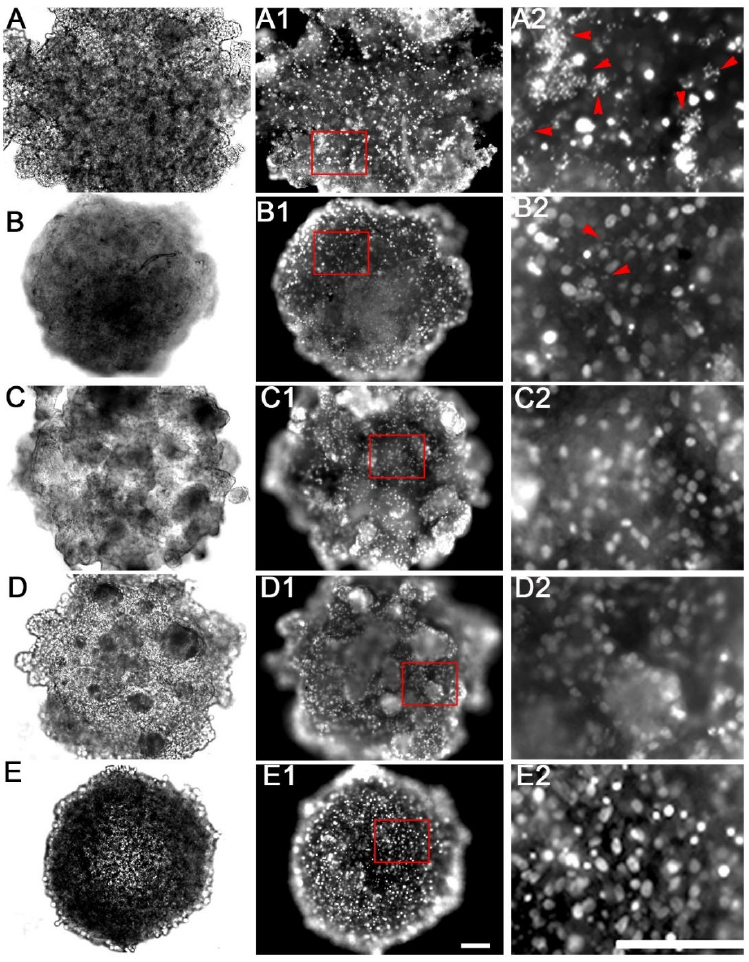
Figure 4. Effect of 3g , 3j and 3m on T. cruzi -infected microtissue. Brightfield microscopy images of spheroids from untreated T. cruzi (Dm28c-Luc) infected Vero cells ( A ), treated with Bz ( B ) or pyrazole-imidazoline derivatives ( C – E ). DAPI stained fluorescence images of untreated infected spheroid ( A – A2 ) and after 72 h-treatment with Bz ( B – B2 ), 3g ( C – C2 ), 3j ( D – D2 ) and 3m ( E – E2 ). High magnification of the spheroid region marked in red (insert) ( A – E2 ). Note the presence of intracellular amastigote on microtissue (arrowheads). The viability of intracellular parasites in the microtissue was measured, by the addition of luciferin, after 3g , 3j , 3m , and Bz treatment (72 h). The luminescence intensity data, represented as arbitrary luminescence unit (ALU), revealed a high parasite load in untreated infected microtissues (ALU = 175,040 ± 24,826) (Figure 5). A significant reduction in the viability of intracellular parasites was demonstrated with 3g (ALU = 36,130 ± 5764), 3j (ALU = 39,001 ± 9952), and 3m (ALU = 12,683 ± 3976) compared to the untreated infected microtissues (Figure 5). Among the compounds analyzed, 3m stands out for reducing microtissue infection by 93%, with a trypanocidal activity profile like Bz (ALU = 18,858 ± 3726) (Figure 5).